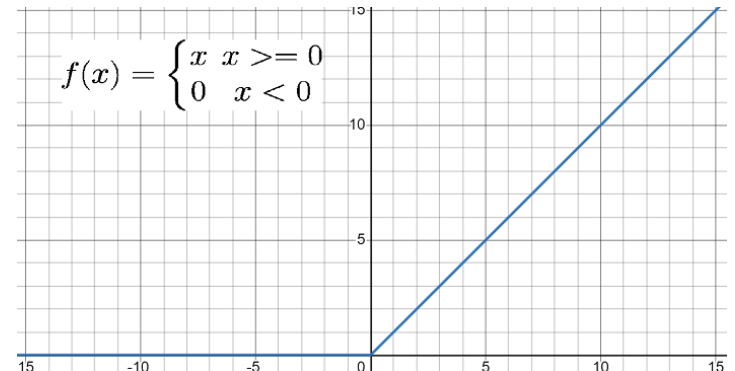
Figure 11. Relu Activation Function.